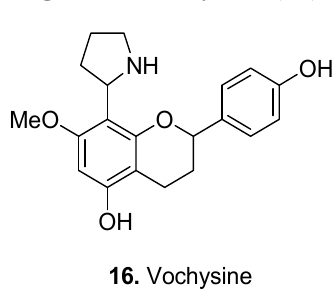
Figure 8. Vochysine ( 16 ).